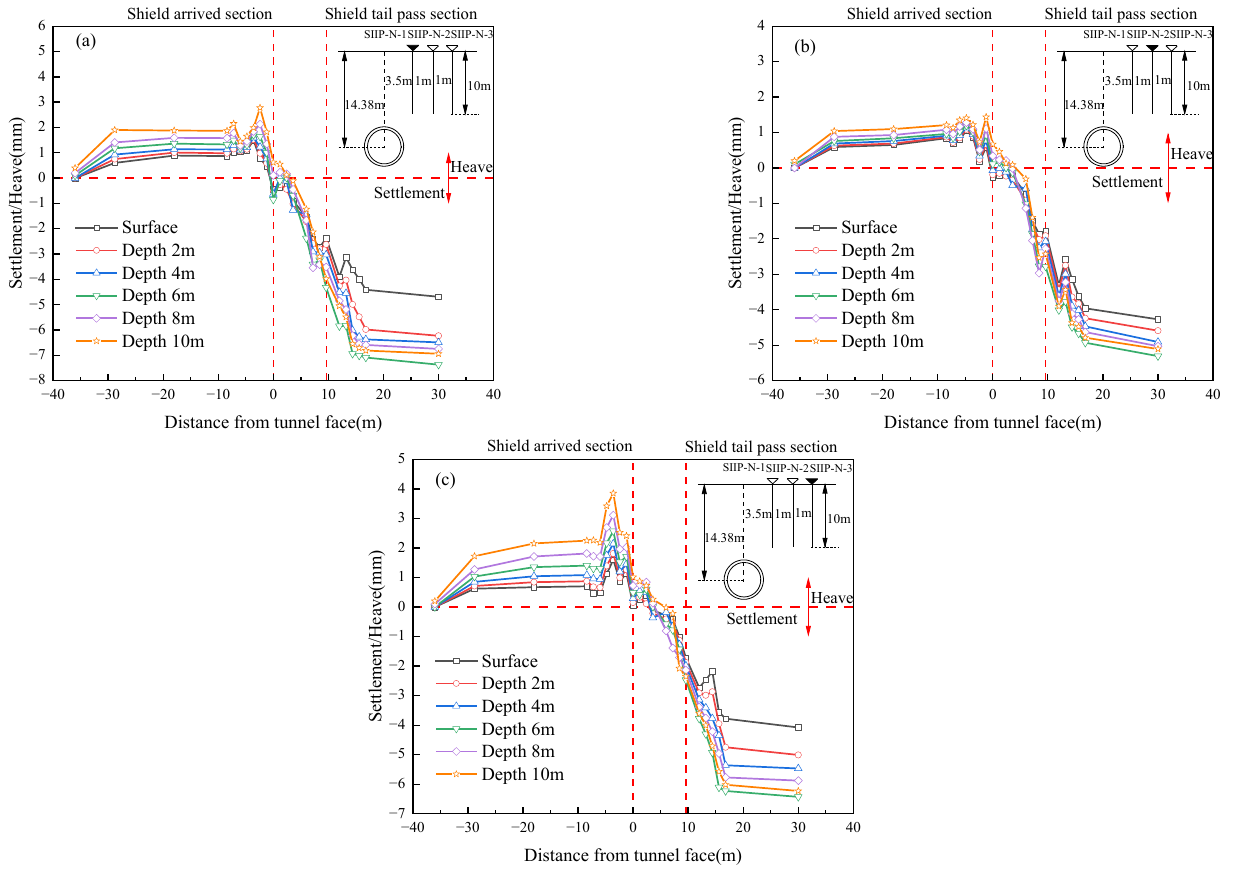
Figure 10. Vertical displacement of stratum soil in section B: ( a ) SIIP-N-1; ( b ) SIIP-N-2; and ( c ) SIIP-N-3.